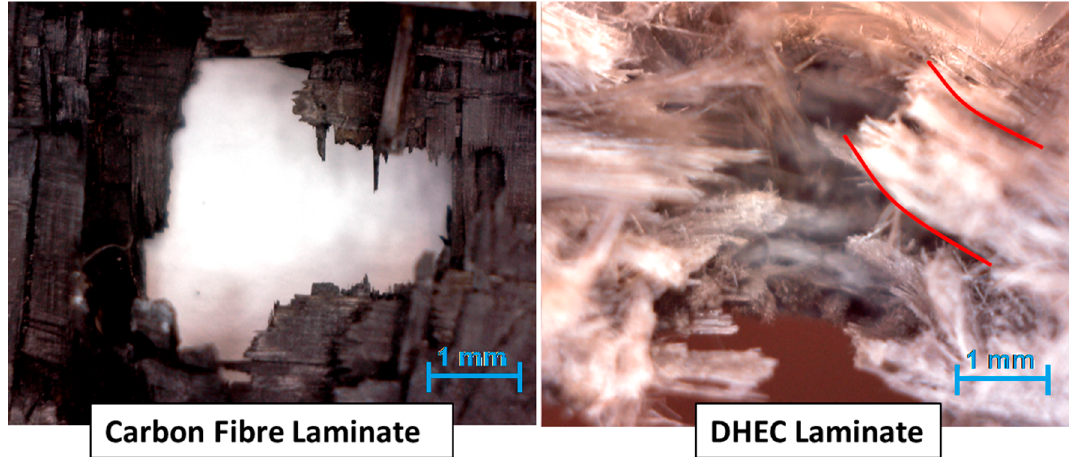
Figure 3. The DHEC laminates (original picture from the author of the chapter) [33].